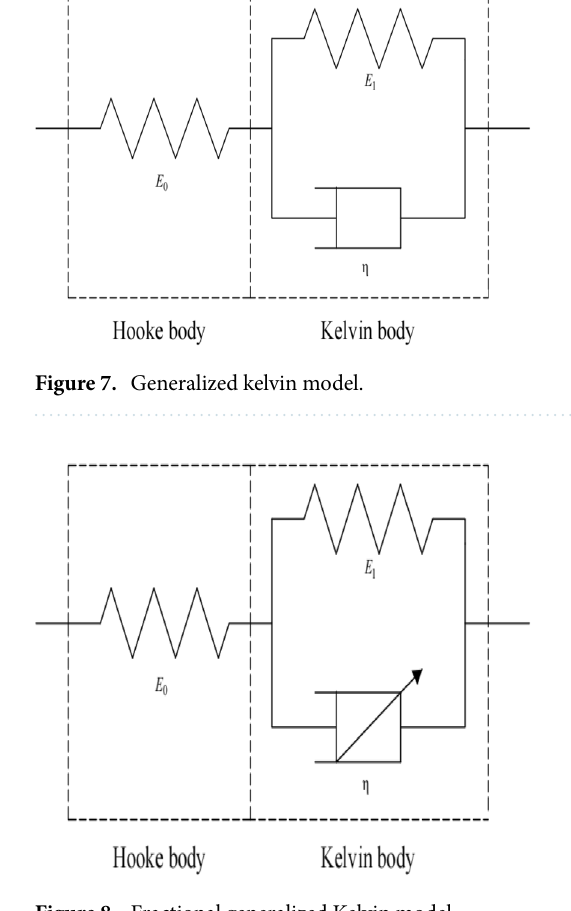
Figure 8. Fractional generalized Kelvin